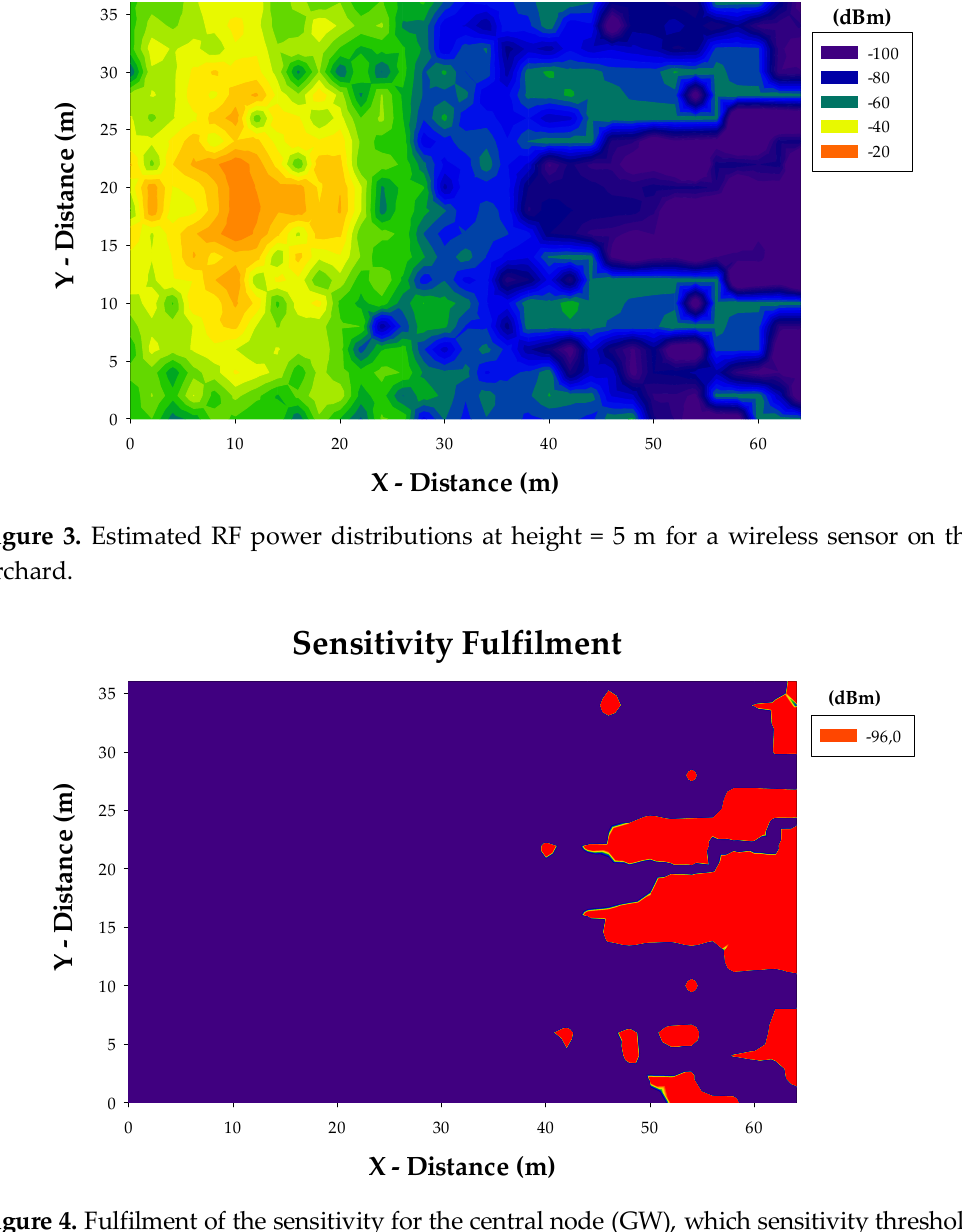
Figure 4. Fulfilment of the sensitivity for the central node (GW), which sensitivity threshold is −96